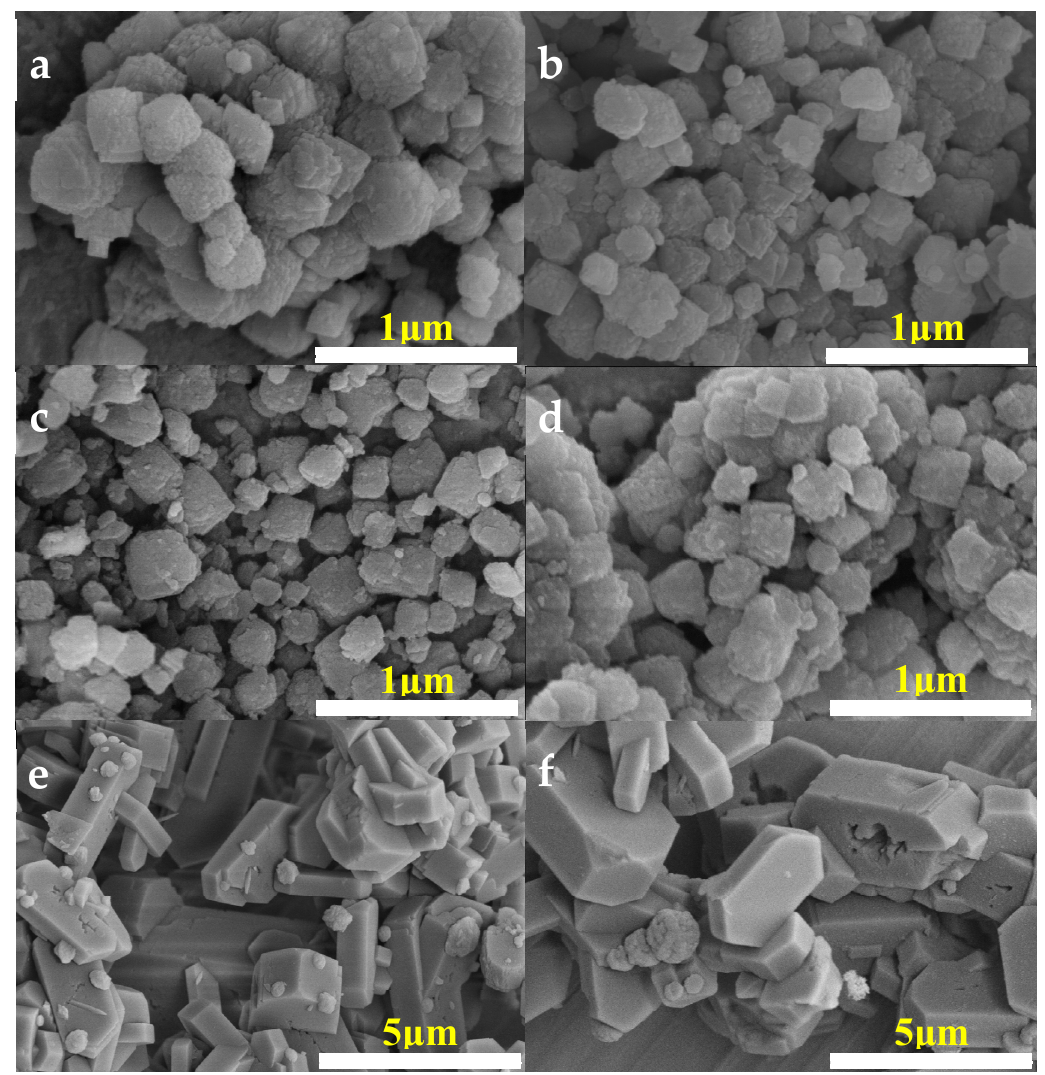
Figure 4. SEM images: ( a ) HBEA-25, ( b ) HBEA-280, ( c ) HBEA-500, ( d ) CeBEA-25, ( e ) ZSM-5, ( f ) Ce- ZSM-5.